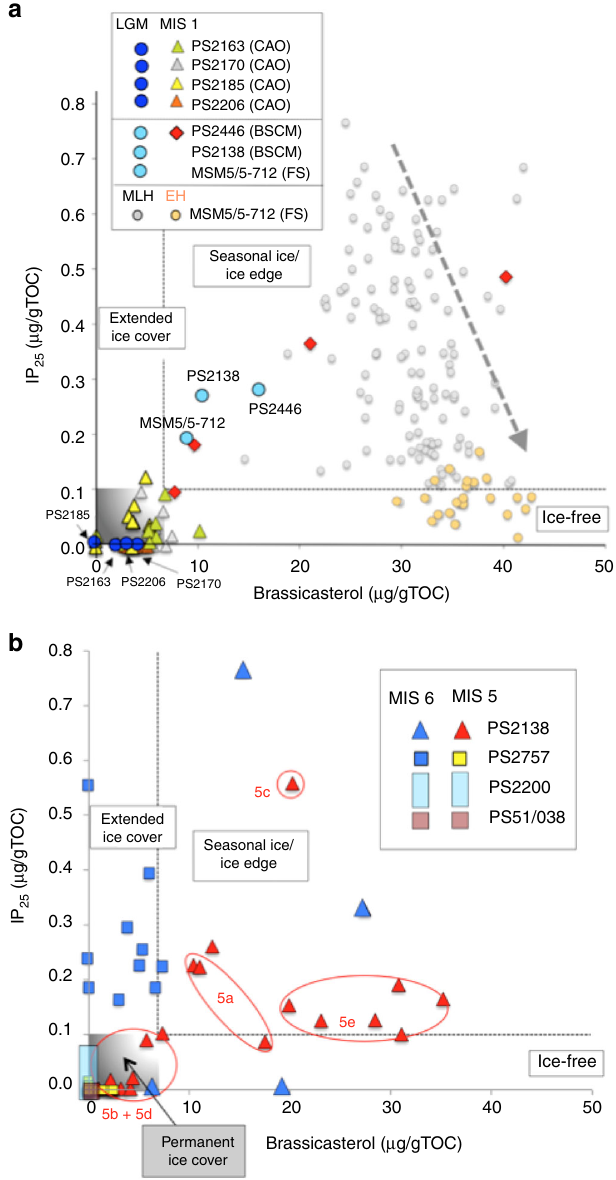
Fig. 3 IP 25 vs. brassicasterol plot, indicative for sea ice conditions. Based on this plot, a classi fi cation of sea ice conditions into permanent sea ice, extended sea ice, seasonal sea ice (ice edge), and ice-free is possible. The gray box close to the origin marks “ permanent/perennial sea ice conditions ” characterized by zero or near-zero concentrations of IP 25 and brassicasterol. a Last Glacial Maximum ( LGM ) and MIS 1 conditions for selected cores from the central Arctic Ocean ( CAO ), the Barents Sea continental margin ( BSCM ) and Fram Strait ( FS ) 36 and Early Holocene ( EH ) and Middle-Late Holocene ( MLH ) data from Fram Strait Core MSM5/ 5-712 32 ). b Data from cores PS2200-5, PS51/38-3, PS2757-8, and PS2138-2 representing the MIS 6 and MIS 5 time intervals (this study). For MIS 5 of Core PS2138-2, 5a, 5b, 5c, 5d, and 5e data are shown meters in thickness. The data from cores PS2757-8 and PS2138-2 (Figs. 2c, d, 3b), on the other hand, do not support the hypothesis of such a giant late MIS 6 ice shelf. Our biomarker proxy records indicate at least occasionally open-water conditions, i.e., an ice edge situation, that allowed phytoplankton and ice algae pro- duction as well as increased fl ux of terrigenous matter (Fig. 5a; cf., Supplementary Fig. 1).